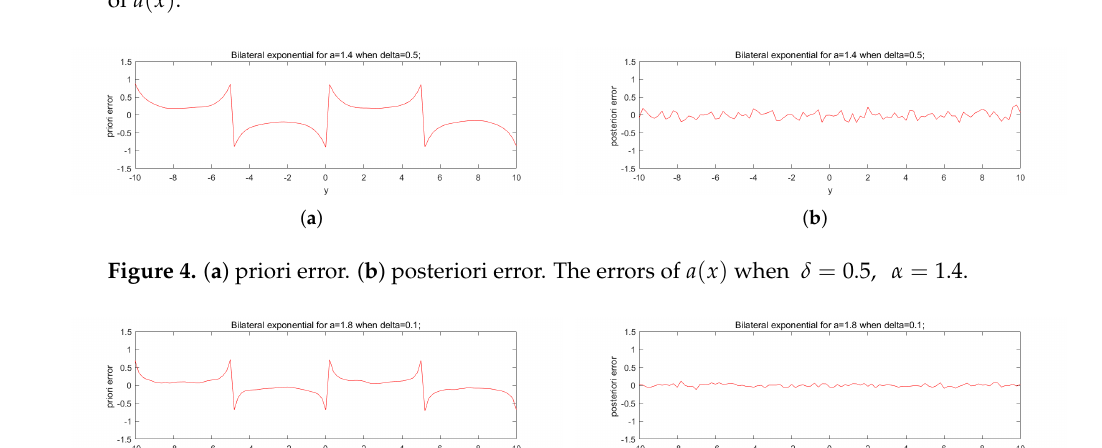
Figure 3. ( a ) δ = 0.5, α = 1.4 . ( b ) δ = 0.5, α = 1.8 . The exact solution and the regularized solution of a ( x ) .